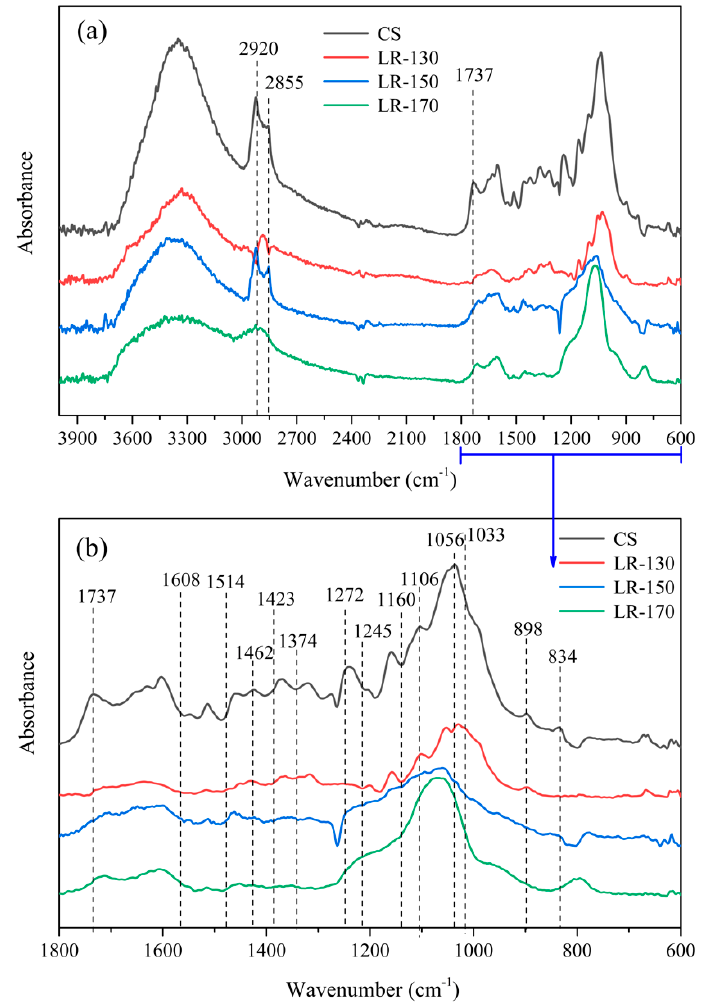
Figure 3. The ATR–FTIR spectra of CS and liquefaction residues ( a ), the distinctive region from 1800–600 cm − 1 of the ATR–FTIR spectra ( b ).